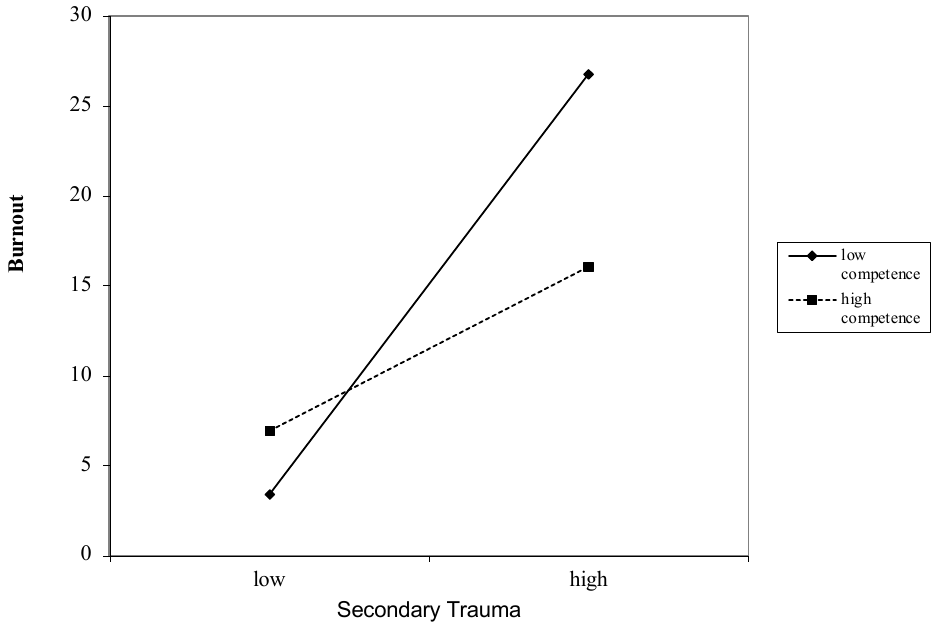
Figure 2. Graph of interaction plot between secondary trauma and competence. Perceived competence moderates the relationship between secondary trauma and burnout, such that those with low competence (1 SD below the mean) and high secondary trauma reported greater burnout.